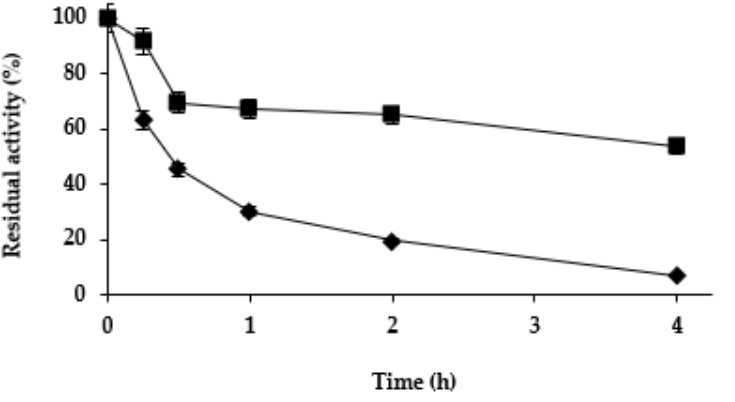
Figure 2. Thermal inactivation courses of agarose C8-TLL and Purolite C18-TLL. Other specifications are described in Methods. Agarose C8-TLL (rhombus) and Purolite C18-TLL (squares).